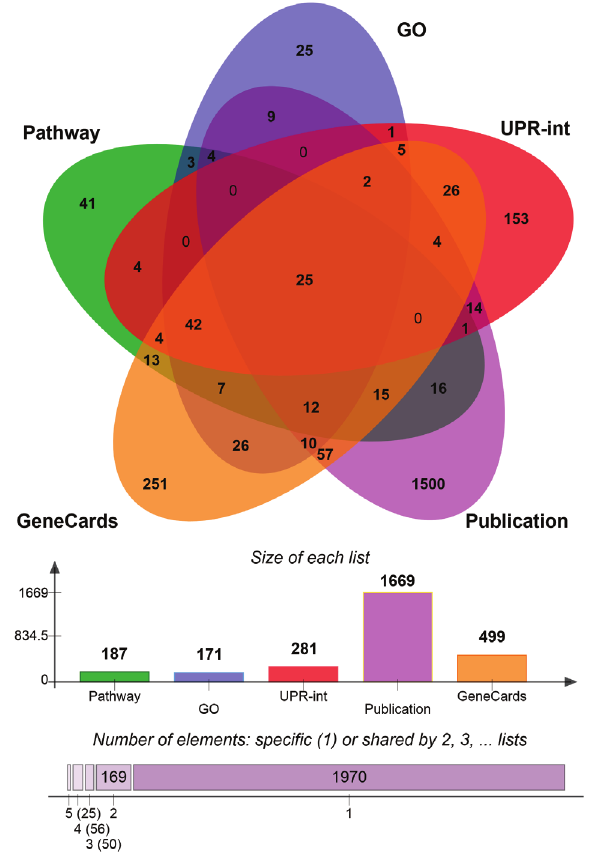
Supplementary Figure 1. Comparison of UPR gene lists. Venn diagram comparing the three different UPR genes lists generated.